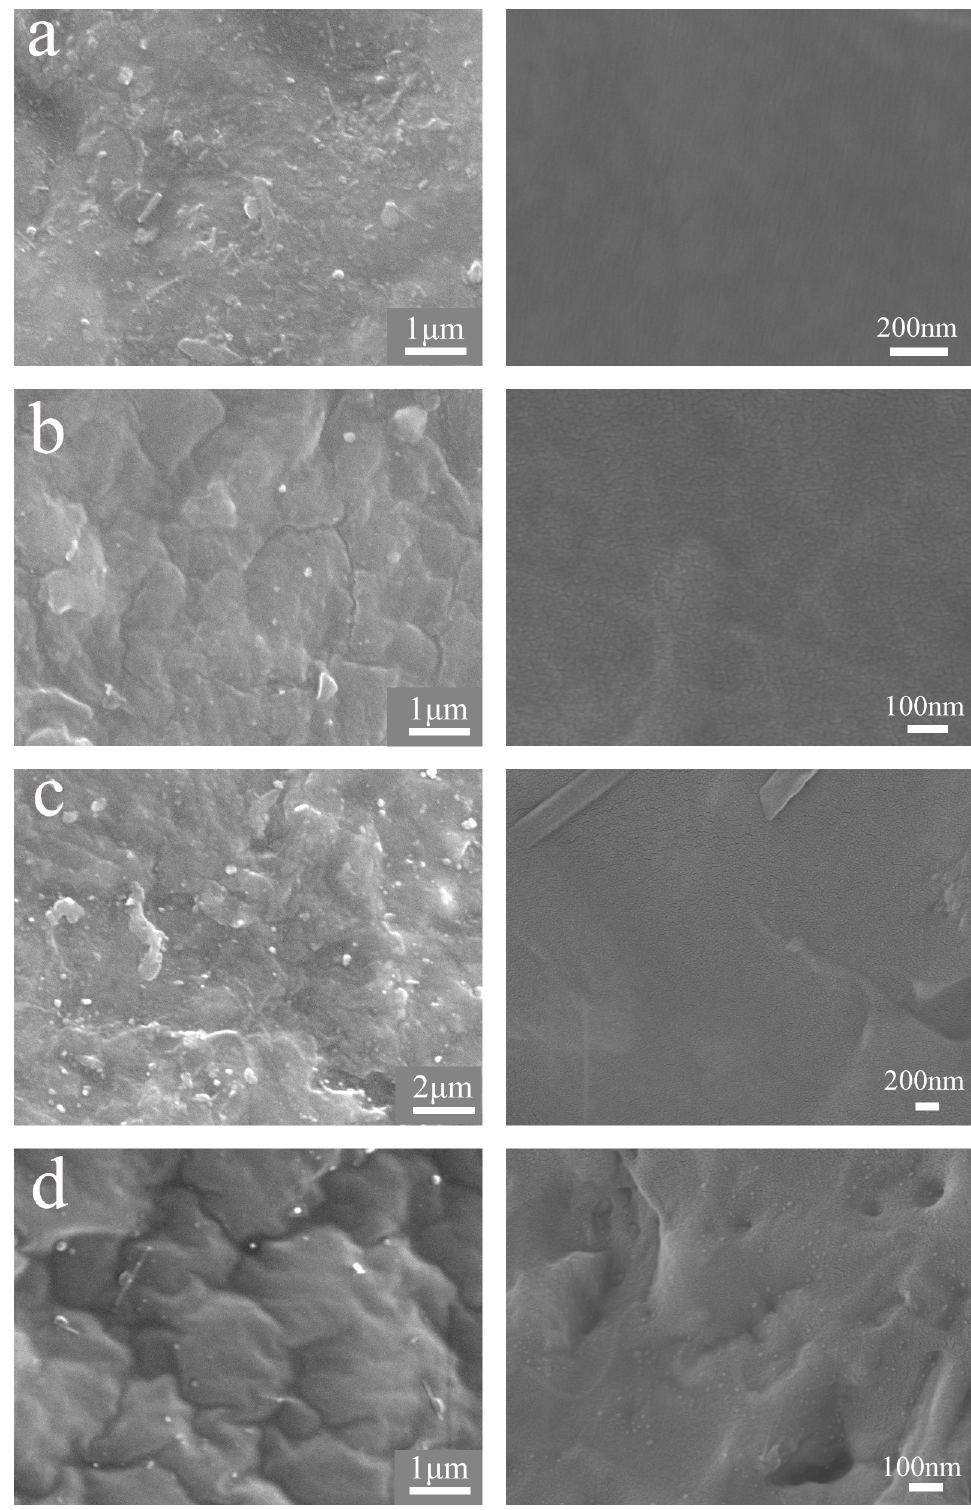
Figure 7. SEM images of the surface ( left ) and cross-sectional ( right ) morphologies of 0.15% GO-TBPU ( a ), 0.35% GO-TBPU ( b ), 1.5% GO-TBPU ( c ), and 5% GO-TBPU ( d ).